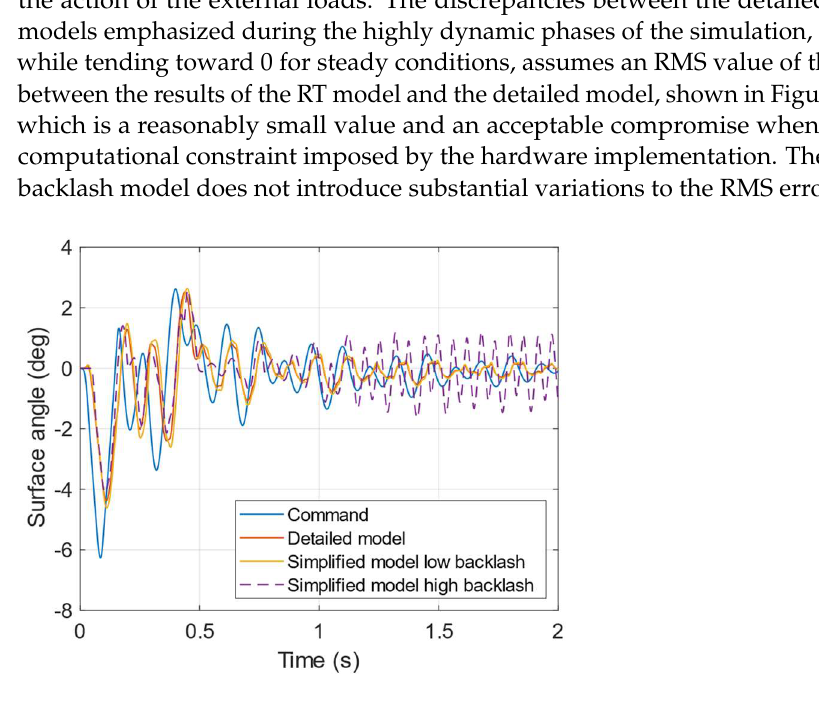
Figure 12. Comparison between detailed model and RT model with low and high levels of